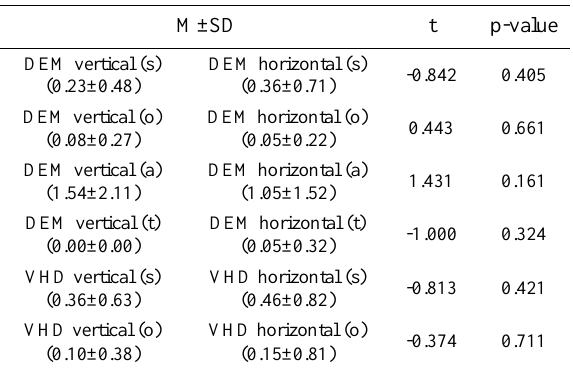
Comparison of errors in DEM and VHD Units: number M±SD t p-value